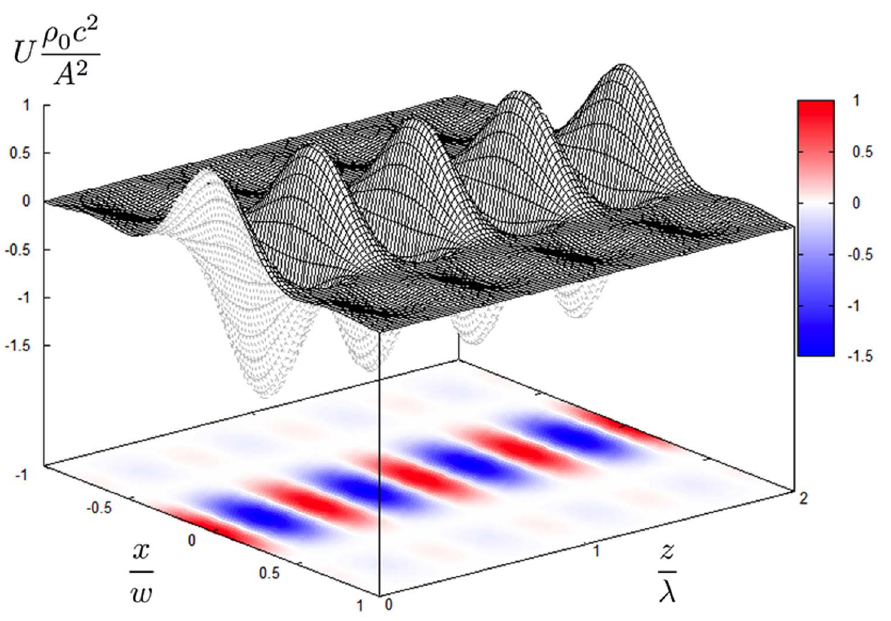
Figure 1. Potential energy distribution of ultrasonic standing wave. This figure is obtained based on Eqs. (1) and (2). The horizontal axes x/w and z/ l are the radial and axial directions of the beam, respectively. The vertical axis is the normalized potential energy. The gradient of this distribution gives the force on a small particle.